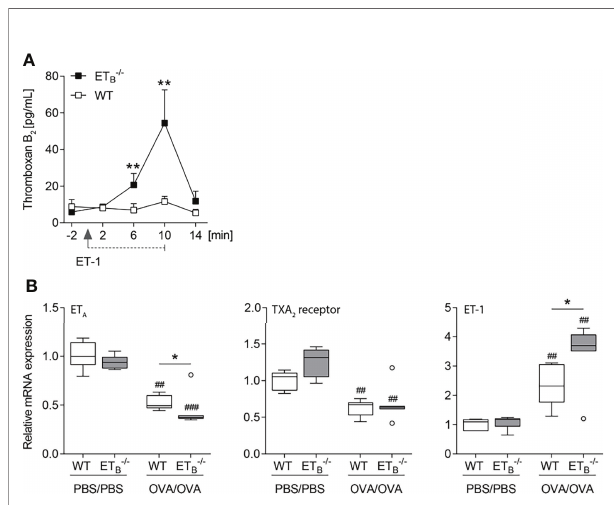
FIGURE 6 | ET-1 - mediated thromboxane release is increased in ET B-/- mice. (A) In isolated perfused lungs of 10- to 12-wk-old rescued endothelin B receptor- de fi cient (ET B-/- ) and corresponding wild-type (WT) mice, perfusate samples were collected 2 min before application of 100 nmol/L ET-1 (for 10 min), and 2, 6, 10, and 14 min after the start of ET-1 application, and TXB 2 levels were determined. The detection limit was 7.8 pg/ml. Values are given as mean and SEM ( N = 7), and analyzed using Mann – Whitney U tests at each time point comparing both groups. (B) ET B-/- and corresponding WT mice were systemically sensitized with OVA (or PBS as control) and repeatedly exposed to aerosolized OVA (OVA/OVA) or PBS (PBS/PBS). Forty-eight hours after the last inhalative OVA challenge, lungs of 15- to 17-wk-old mice were isolated for mRNA expression analyses by quantitative PCR. Relative quanti fi cation of mRNA was performed using the comparative C t method. Data are represented as box plots depicting median, quartiles, and ranges excluding outliers ( open circles ), and analyzed using Mann – Whitney U test; N = 6 – 7 per group. # indicates signi fi cant difference between OVA/OVA vs. the corresponding PBS/PBS group, * indicates signi fi cant difference between ET B-/- vs. the corresponding WT group. * p < 0.05, ** /## p < 0.01, ### p <